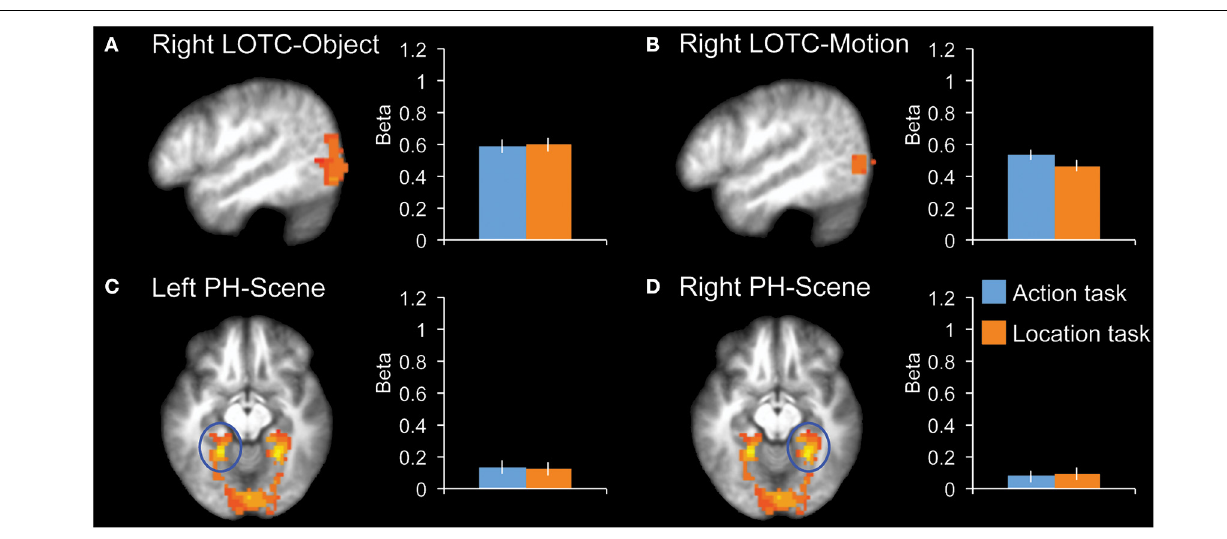
> static dots, x = − 49), (C) left PH-Scene (scenes > hands + tools + animals, z = − 9), (D) Right PH-Scene (scenes > hands + tools + animals, z = − 9). All brain activity maps are shown at P < 0 . 005, displayed on the group-average anatomical scan. Error bars reflect within-subject